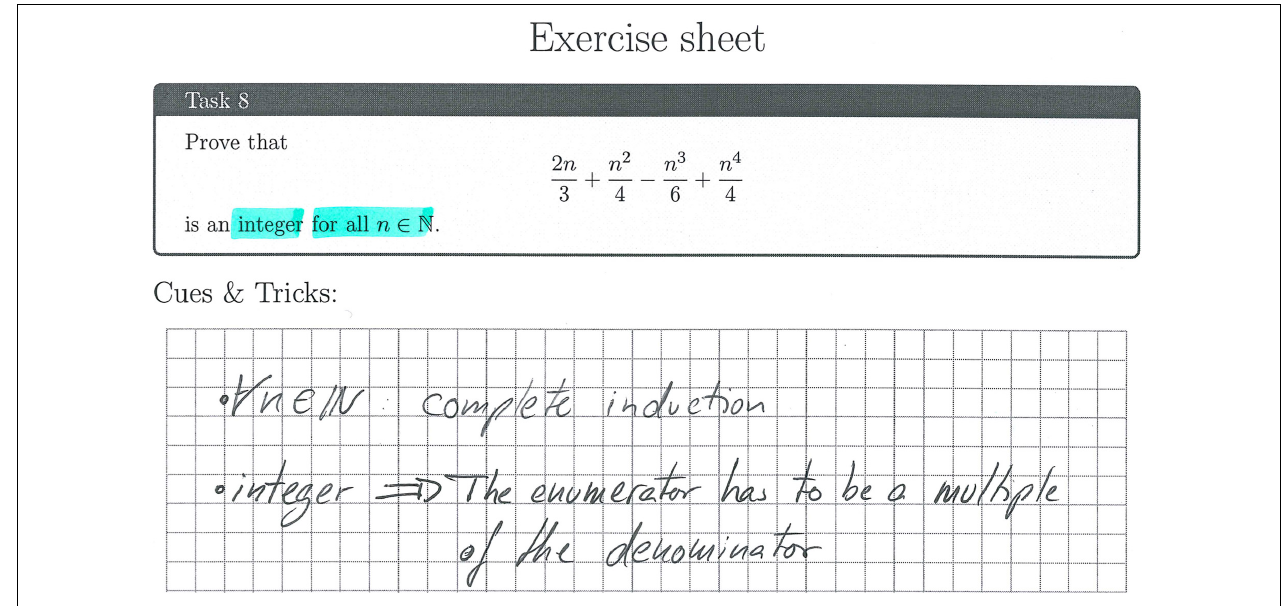
FIGURE 4 | Excerpt of a student’s exercise sheet showing an analysis regarding mathematical strategic knowledge (translated).